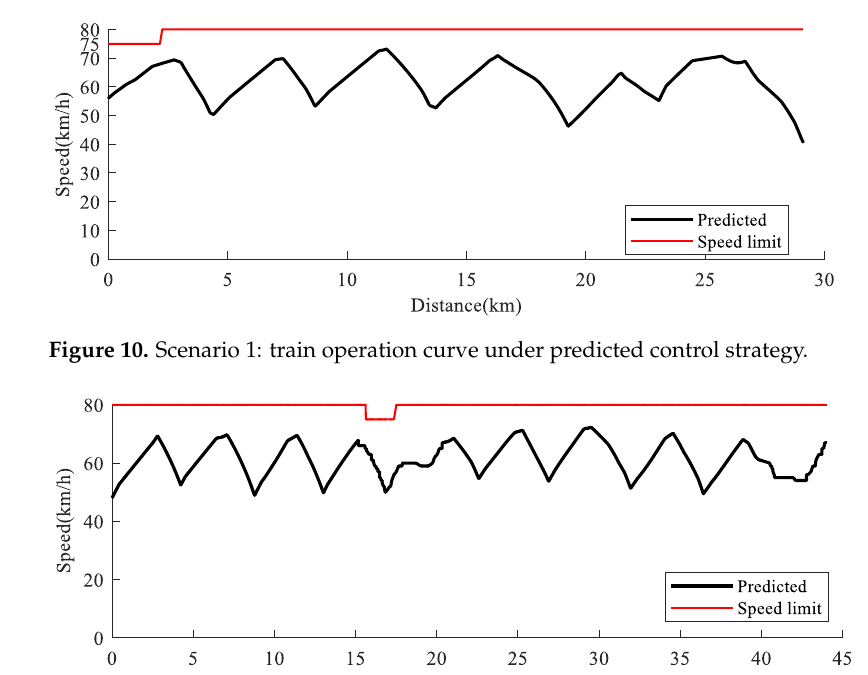
Figure 9. Scenario 2: comparison of predicted and actual control strategy. ( a ) Section from 14 km to 20.5 km. ( b ) Section from 38 km to 44 km